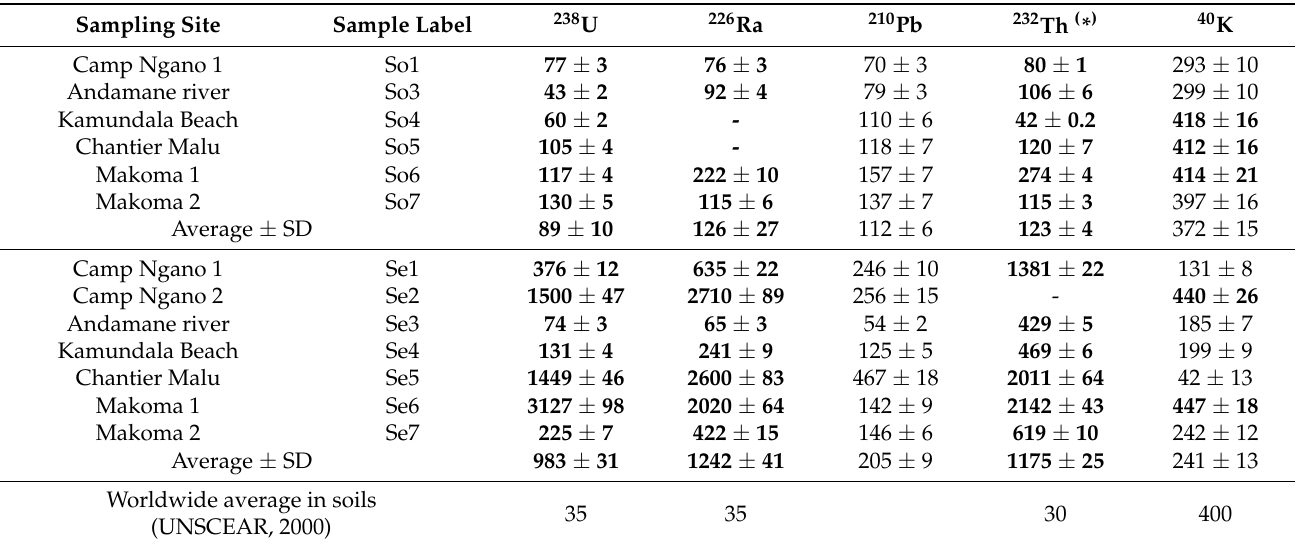
Table 2. Activity concentrations (Bq kg − 1 ± 1 SD dry weight) of naturally occurring radionuclides in soil and sediment samples from the Ulindi River basin. Numbers in bold indicate values above the worldwide average